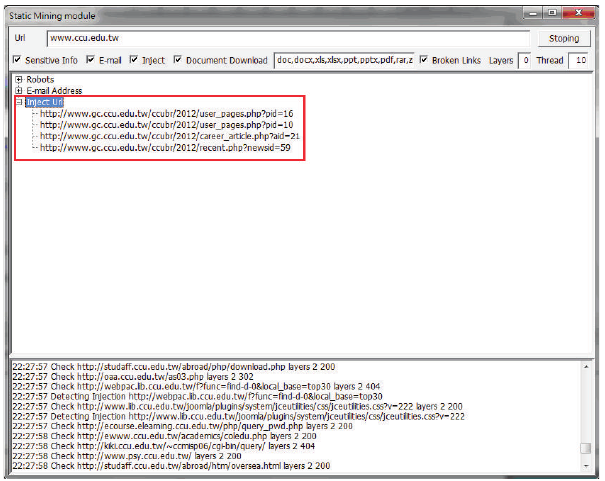
Figure 7: List of SQL injection